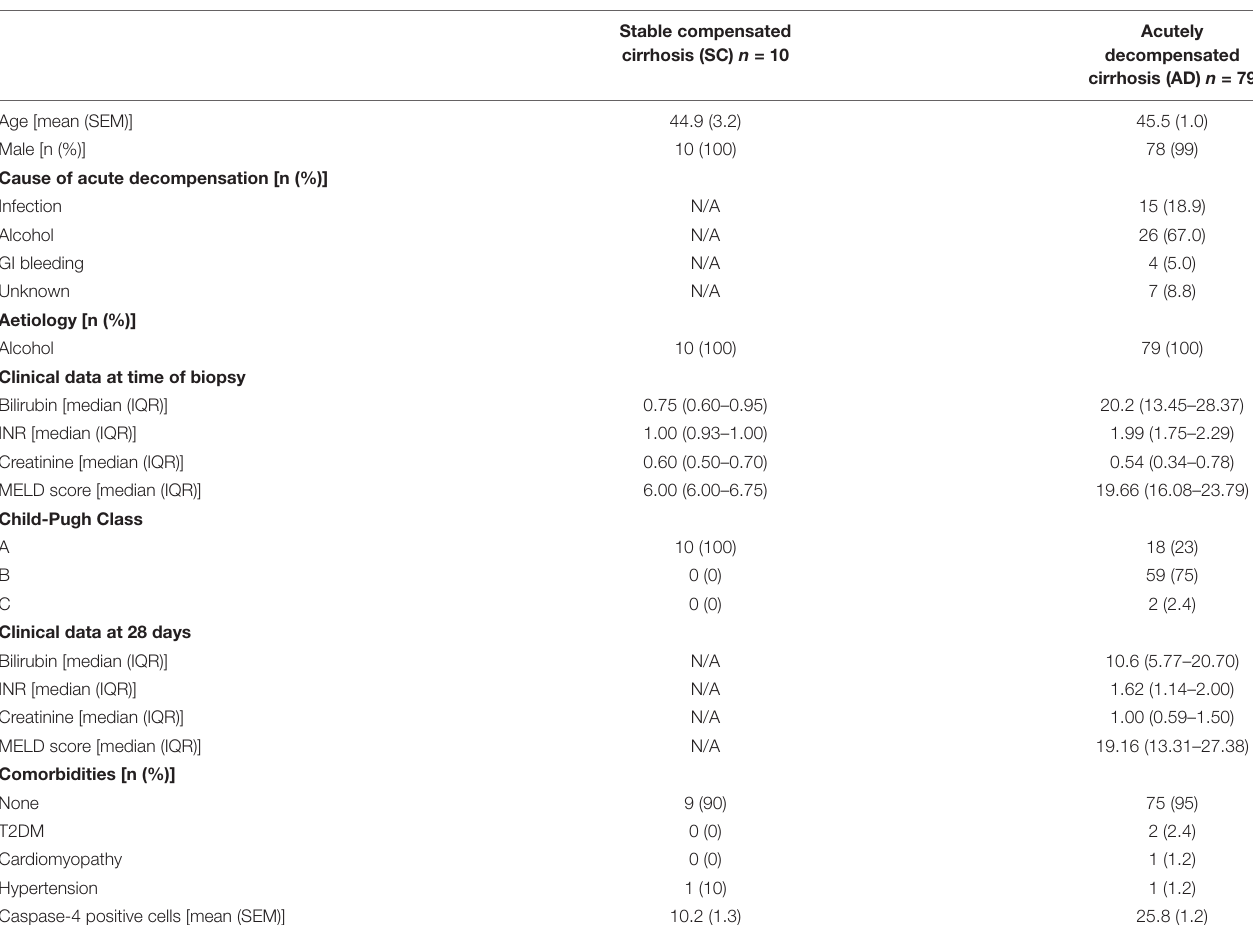
TABLE 1 | Patient characteristics for liver tissue